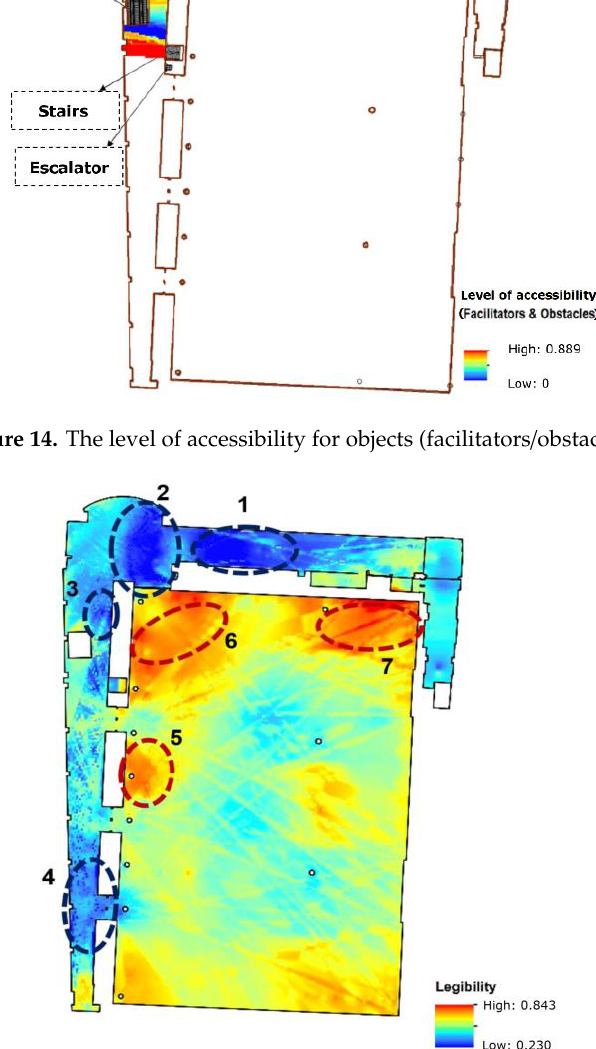
Figure 14. The level of accessibility for objects (facilitators/obstacles) .